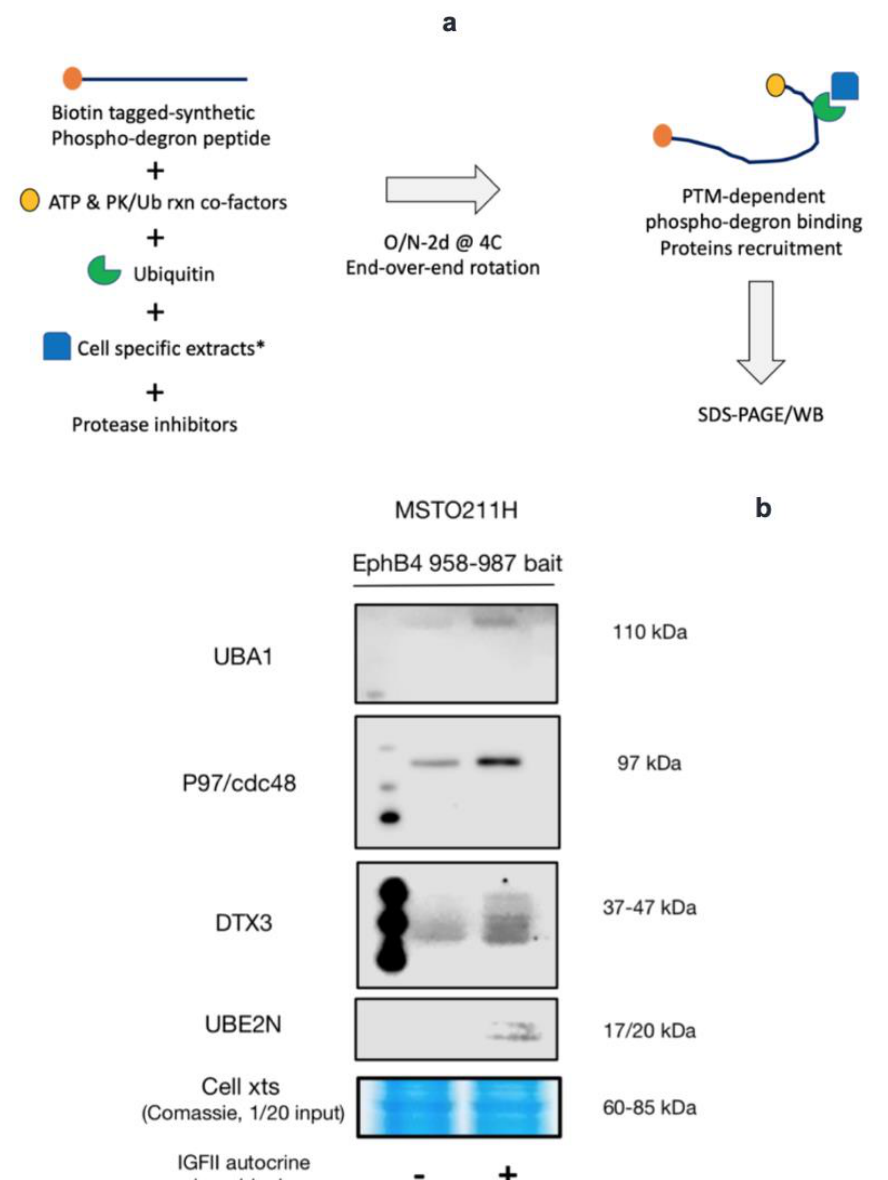
Figure 2. A DTX3-UBE2N-UBA1-Cdc48/p97 protein complex docking to the IGF-II signal-deprived EphB4 Phospho-Degron/PDZ C-terminal region. ( a ) Schematics of the PTM-enhanced EphB4-C-tail pull-down assay. (*) Asterisk in 2a points at the in vivo IGF-II conditional block treatment; ( b ) ability of EphB4 c-Tail to recruit UBA1, UBE2N, DTX3, and p97/cdc48 from MSTO211H lysates following ex vivo autocrine IGF-II loop neutralization.